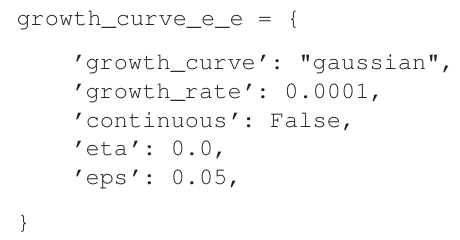
Frontiers in Neuroanatomy |